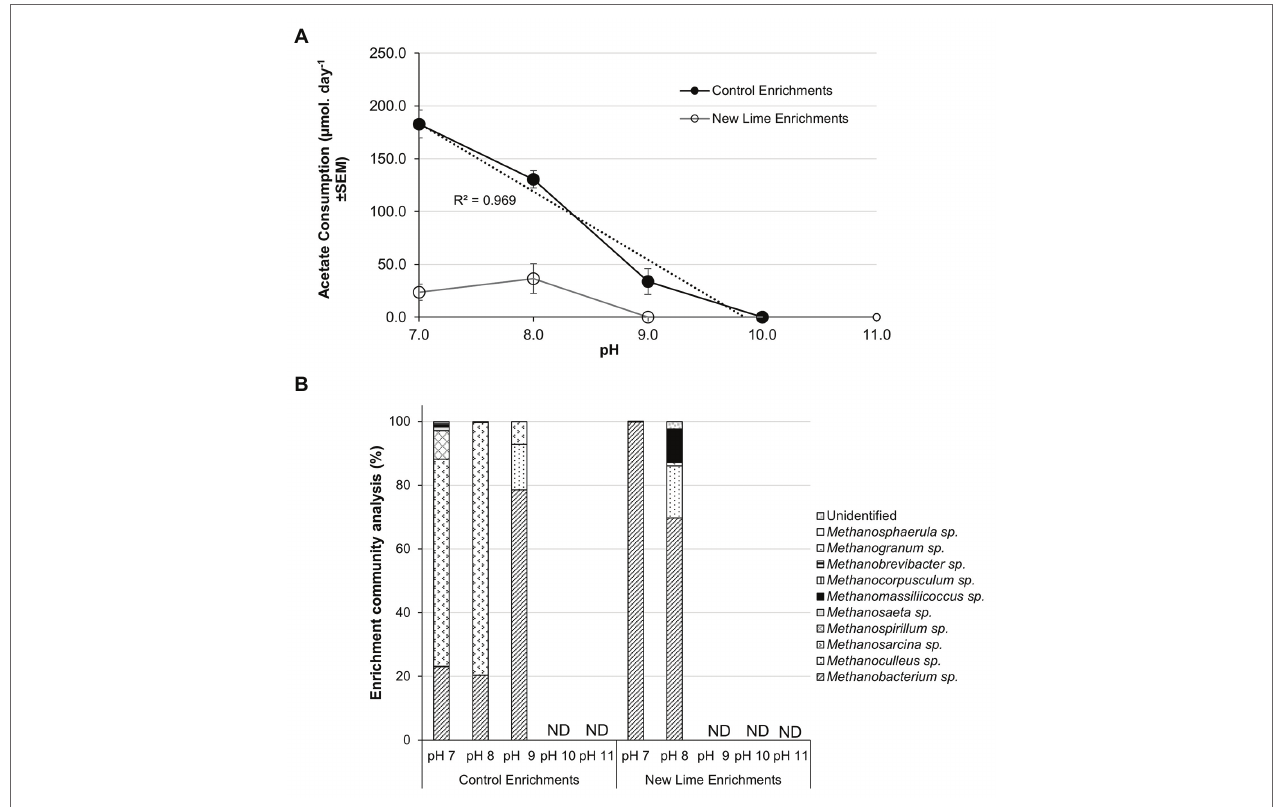
FIGURE 4 | Acetate consumption rates (A) and methanogen populations (B) in sodium acetate enriched microcosms from Control and New lime soils. Increasing pH negatively impacted upon acetate consumption with no acetate consumption observed above pH 9.0 in either the Control ( n = 2 at all pH values) enrichments or the New Lime enrichments ( n = 2 pH 7.0, n = 2 pH 8.0). Methanosarcina spp. and Methanobacterium spp. were the dominant genera in Control enrichments while Methanobacterium sp. were dominant in the New Lime enrichments. ND, none detected (“ n ” denotes the number of replicates